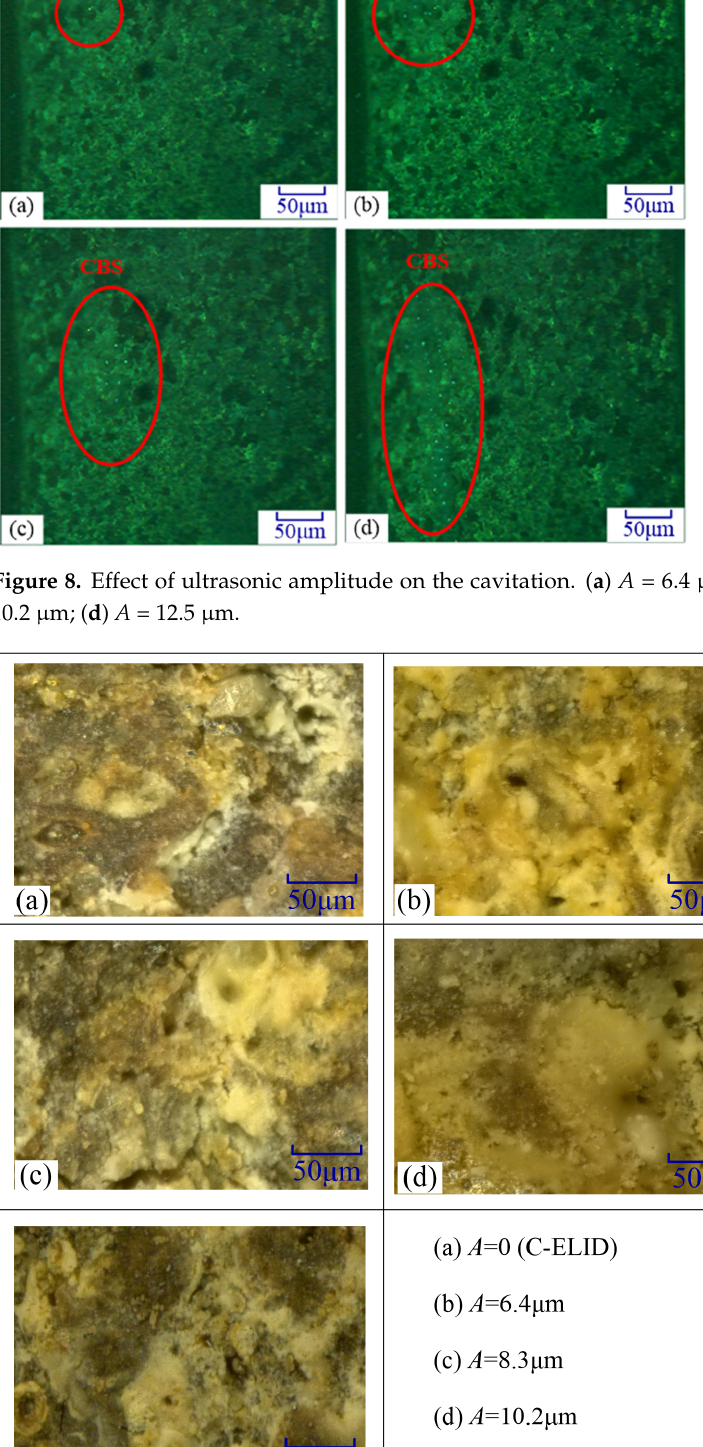
Figure 8. Effect of ultrasonic amplitude on the cavitation. ( a ) A = 6.4 μ m; ( b ) A = 8.3 μ m; ( c ) A = 10.2 μ m; ( d ) A = 12.5 μ m.